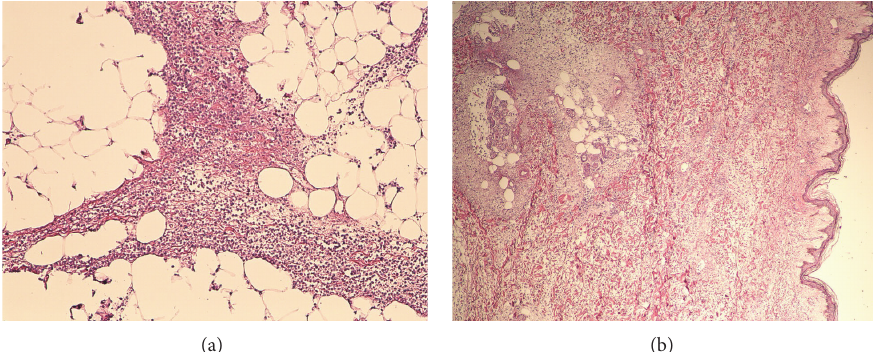
Figure 3: Histopathology: (a) subcutaneous fat with marked acute inflammatory cell infiltrate, comprised of polymorphs, macrophages, and cellular debris; (b) acute inflammation with scattered necrosis and vascular microthrombosis involving dermis, subcutaneous fat, and